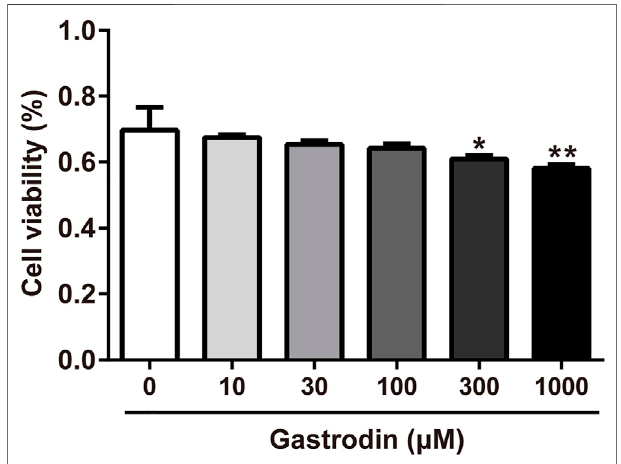
FIGURE 7 | Inhibitory effect of Gastrodin in HepG2 cells. Results were expressed as mean ± SD ( n (cid:1) 3). * p < 0.05, ** p < 0.01 vs Control group.